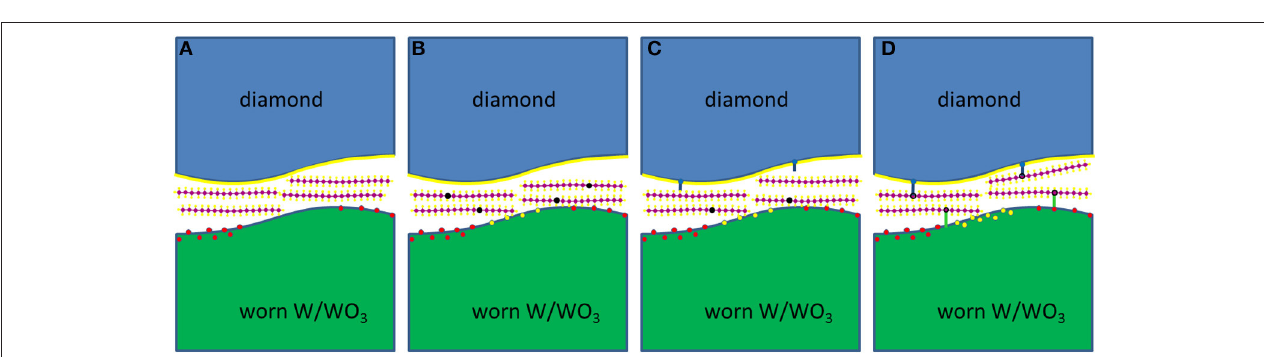
FIGURE 5 | Chemical analysis of the worn tungsten surface after hexadecane-lubricated sliding. (A) SEM image of the wear track on the tungsten counter surface. (B) Auger electron spectroscopy (AES) mapping and XPS of the wear track before and after 45s of sputtering. (C) XPS detail spectra and binding states on the wear track.